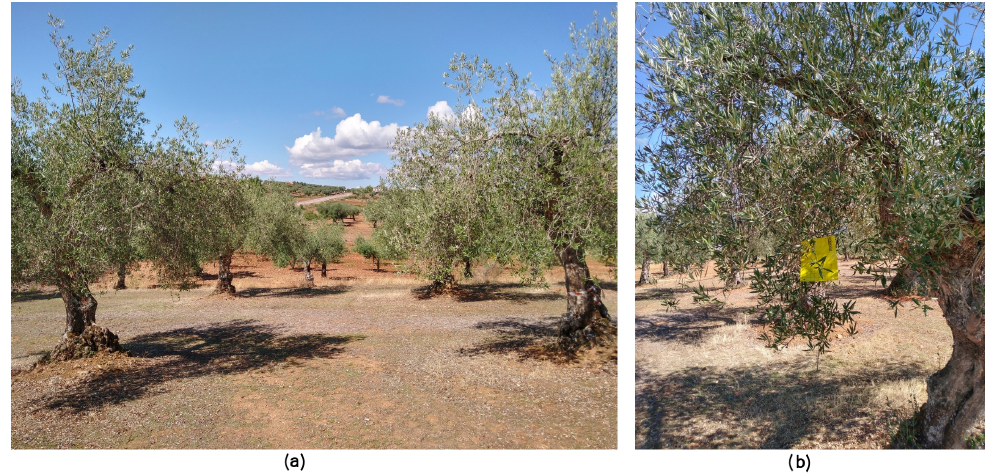
Figure 1. Example of olive-growing space environment complexity. ( a ) A picture of an olive-growing space and trees. ( b ) Detail of a trap fixed in the tree